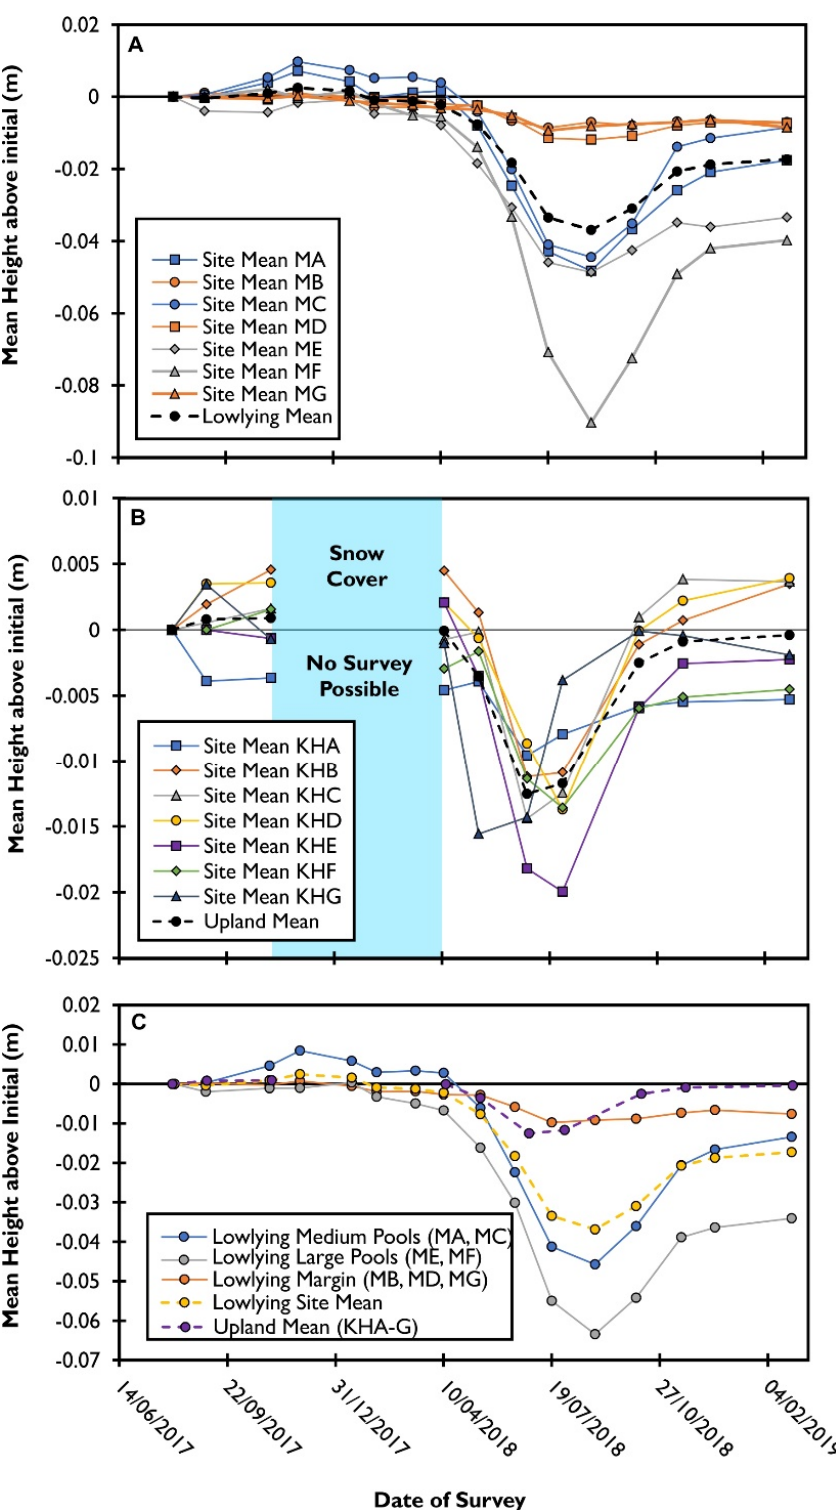
Figure 2. Precise Leveling Measurements of mean motion of benchmarks at each subsite at the ( A ) Low-lying Munsary Site ( B ) upland Knockfin Heights Site and ( C ) a comparison of the mean motion of different meso-scale units within the upland and low-lying sites including whole site mean. Details of individual benchmark motion can be seen in Figures A1 and A2 (Data available at [35]).